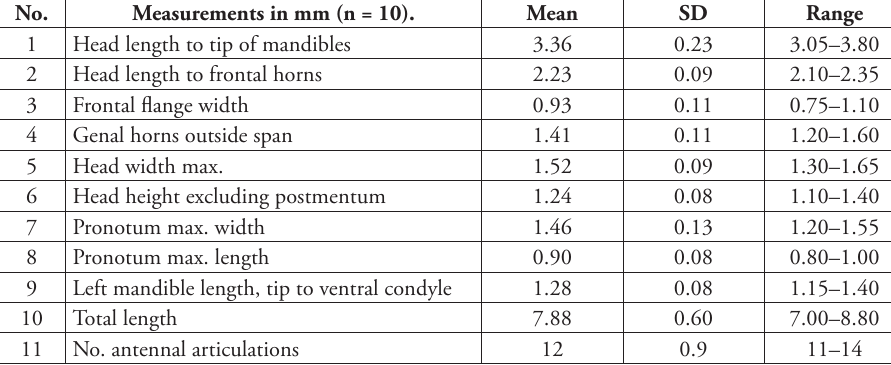
Table 7. Morphometrical measurements for soldiers of Proneotermes perezi . No. Measurements in mm (n =